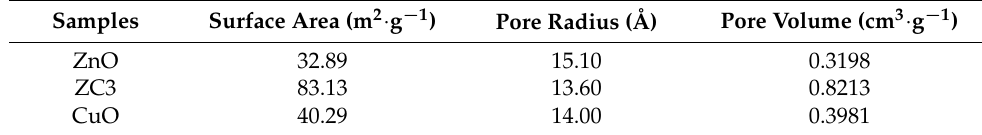
Table 2. Specific surface area and pore properties for the ZnO, CuO, and ZnO/CuO nanoparticles.